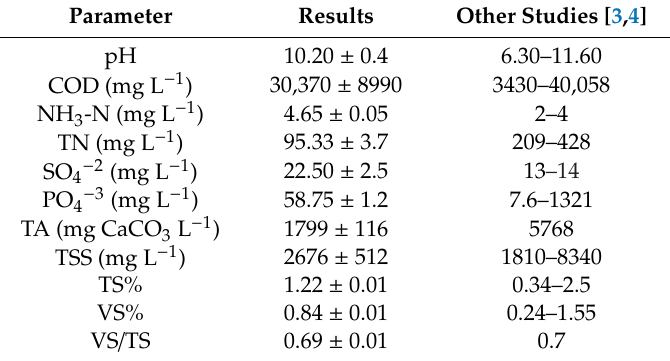
Table 1. Nejayote characterization compared with other studies.